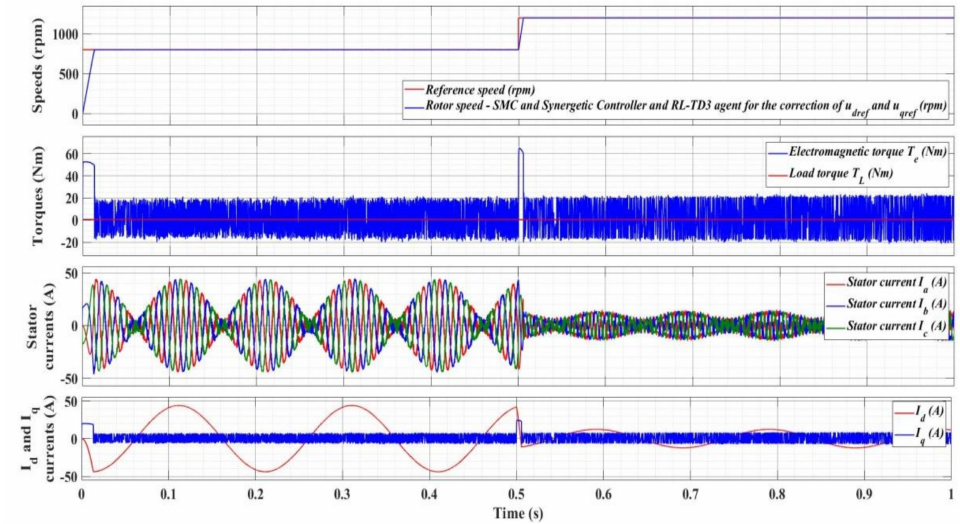
Figure 34. Time evolution for the numerical simulation of the PMSM control system based on control using SMC and synergetic controllers using an RL-TD3 agent for the correction of u dref and u qref